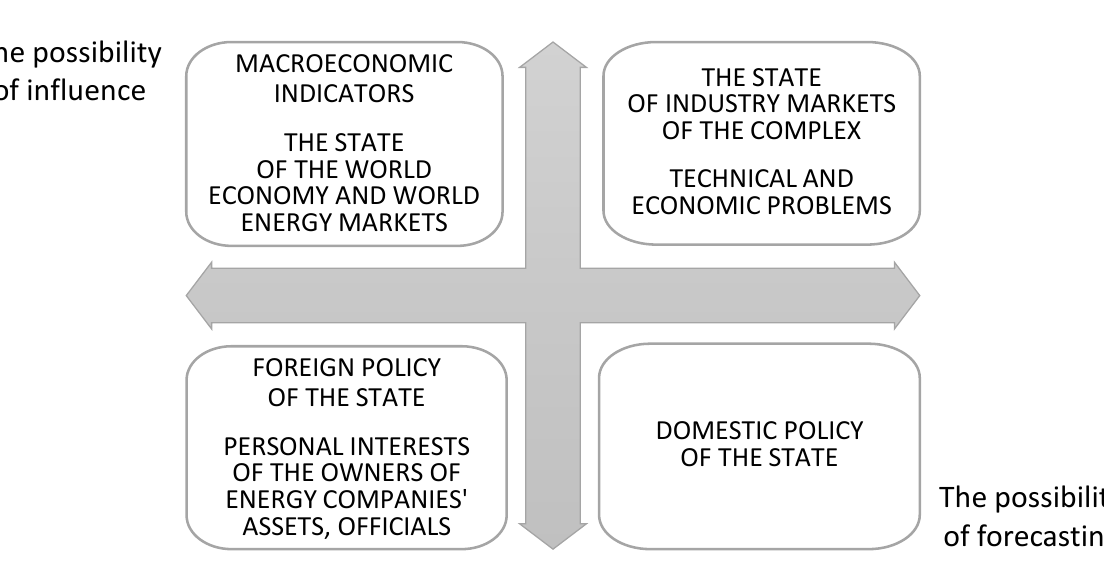
Figure 2. Matrix of factors for forecasting the development of the fuel and energy